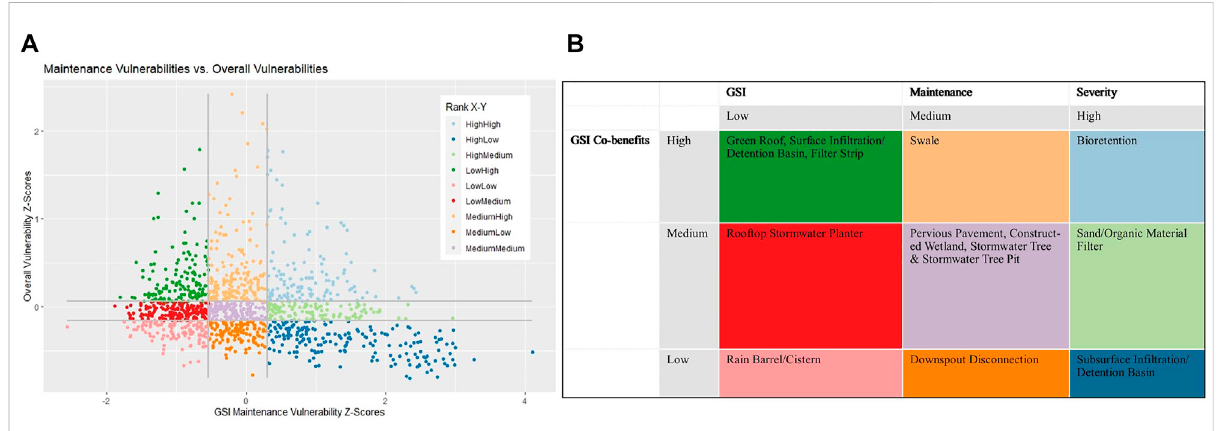
FIGURE 9 (A) Scatterplot of the GSI MNI rankings based on z-scores (X) against the Overall Vulnerability Index rankings (Y). The grey lines represent the separation between Low, Medium, and High vulnerability ranks, where GSI MNI Low is ≤ -0.54, Medium ≤ 0.30, High ≤ 4.11. For the OVI without the GSIMNIincluded,vulnerabilityisrankedwhereLow ≤ -0.16,Medium ≤ 0.06,andHigh ≤ 2.42.Thesevaluesweretakenbyseperatingthedataspreadof both the GSI MNI z-scores and the OVI (without GSI MNI) z-scores and seperating them into three quantiles to represent levels of vulnerability. (B) A decision table to suggest which GSI types are best suited for neighborhoods with different levels of maintenance severity and different co- bene fi t needs. The colors of each box correlate directly with the same color census block group points in Figure